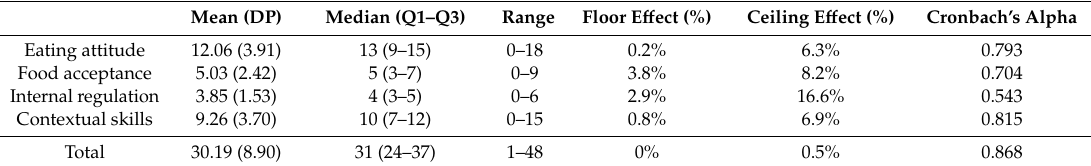
Table 1. The ecSI2.0 ™ BR scores, responsiveness, and internal consistency of the questionnaire ( n = 1810,